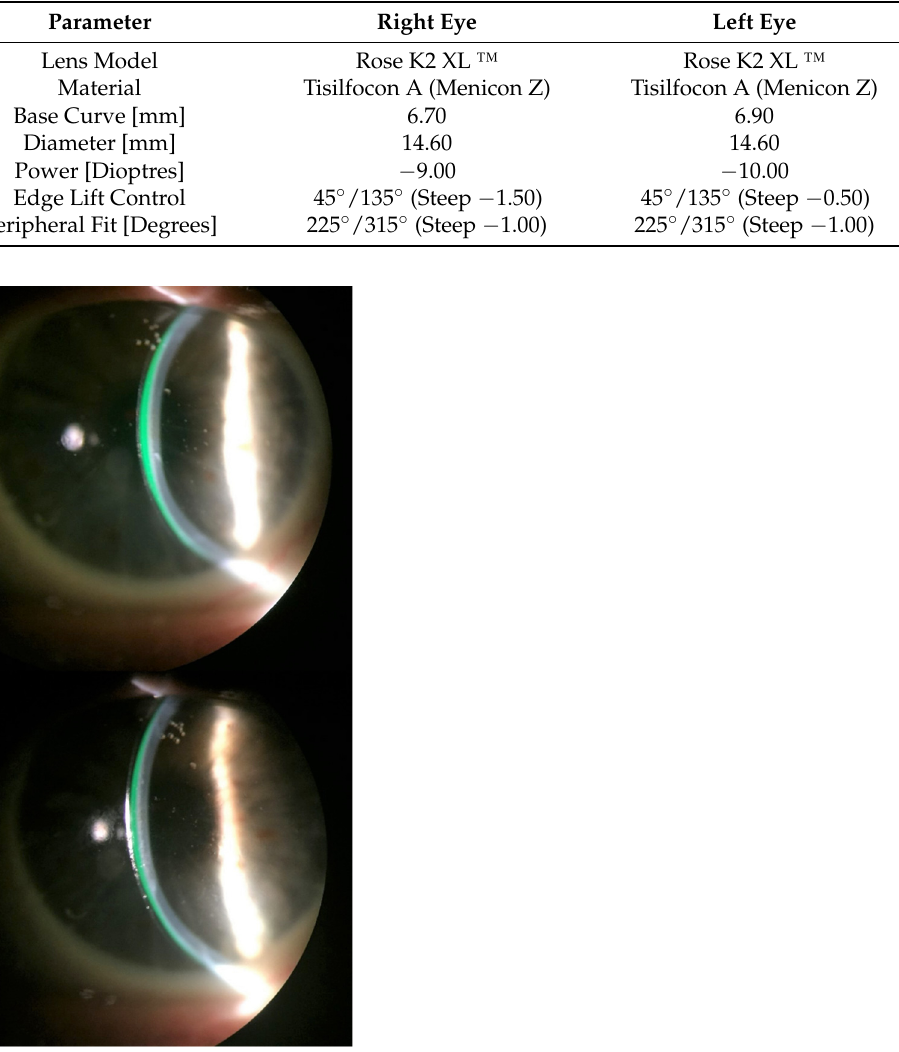
Table 1. Semi-scleral contact lens parameters.